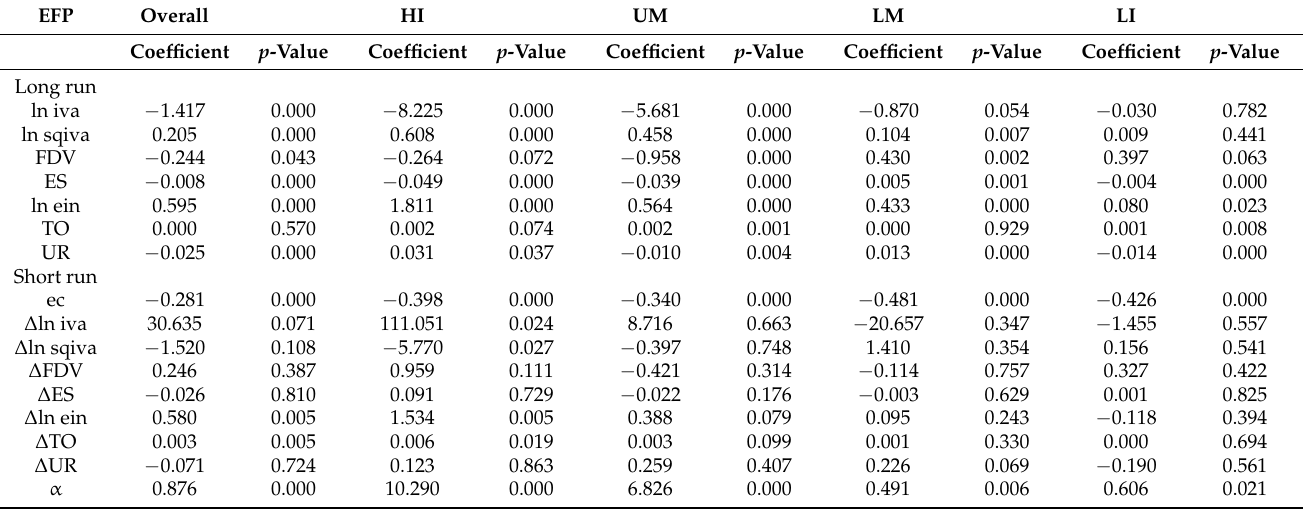
Table 8. The impact of the industrial sector (iva) on EFP.